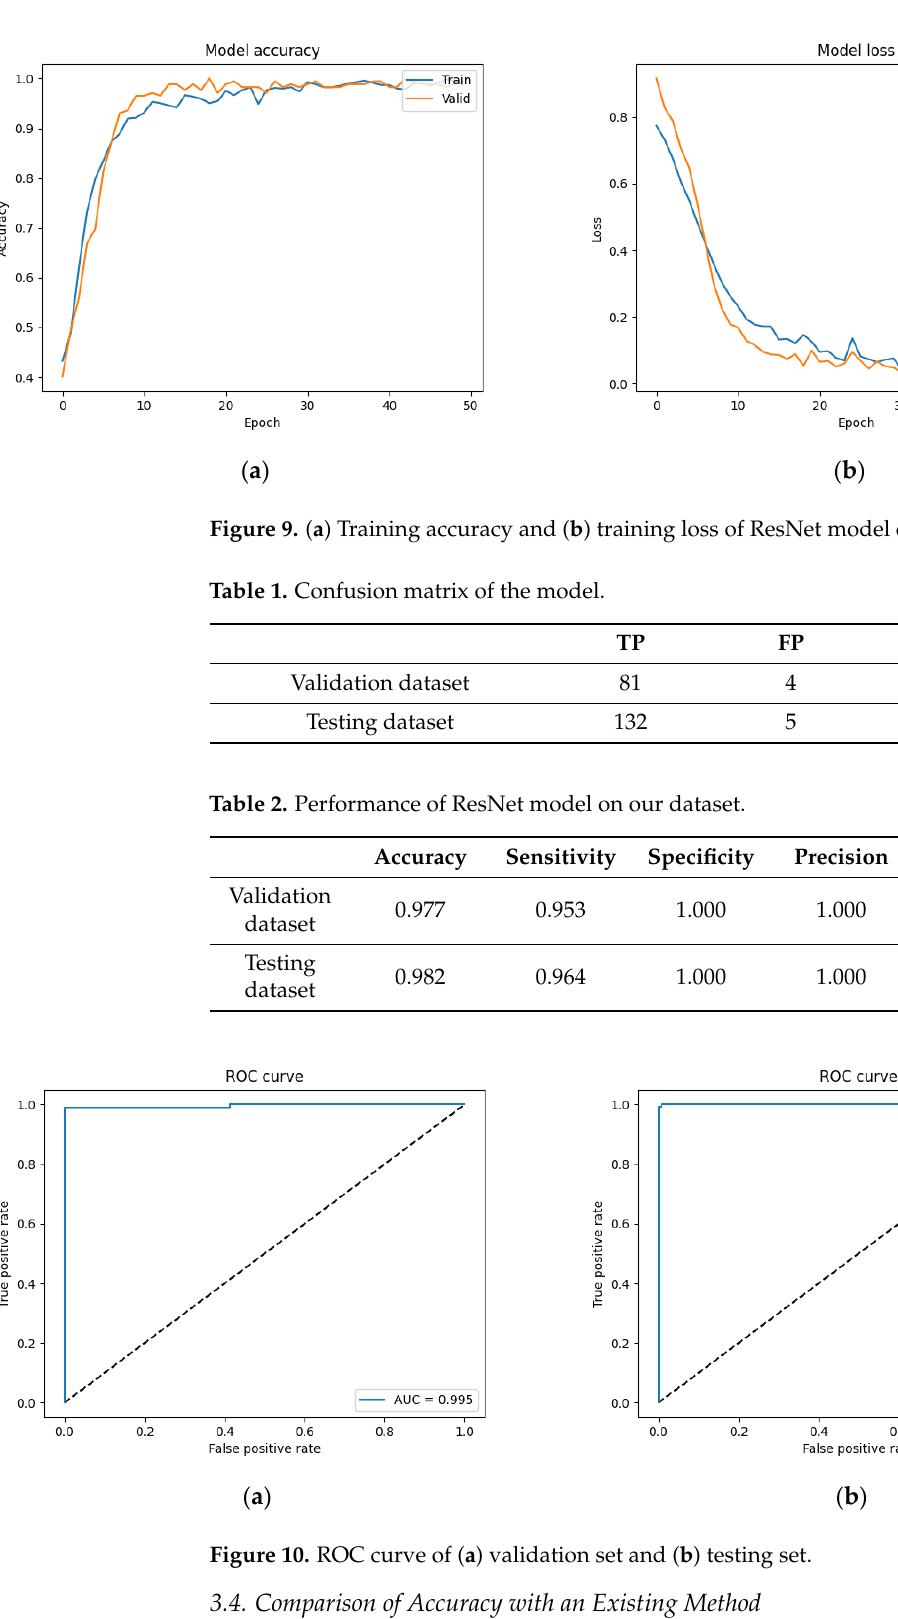
Table 2. Performance of ResNet model on our dataset.